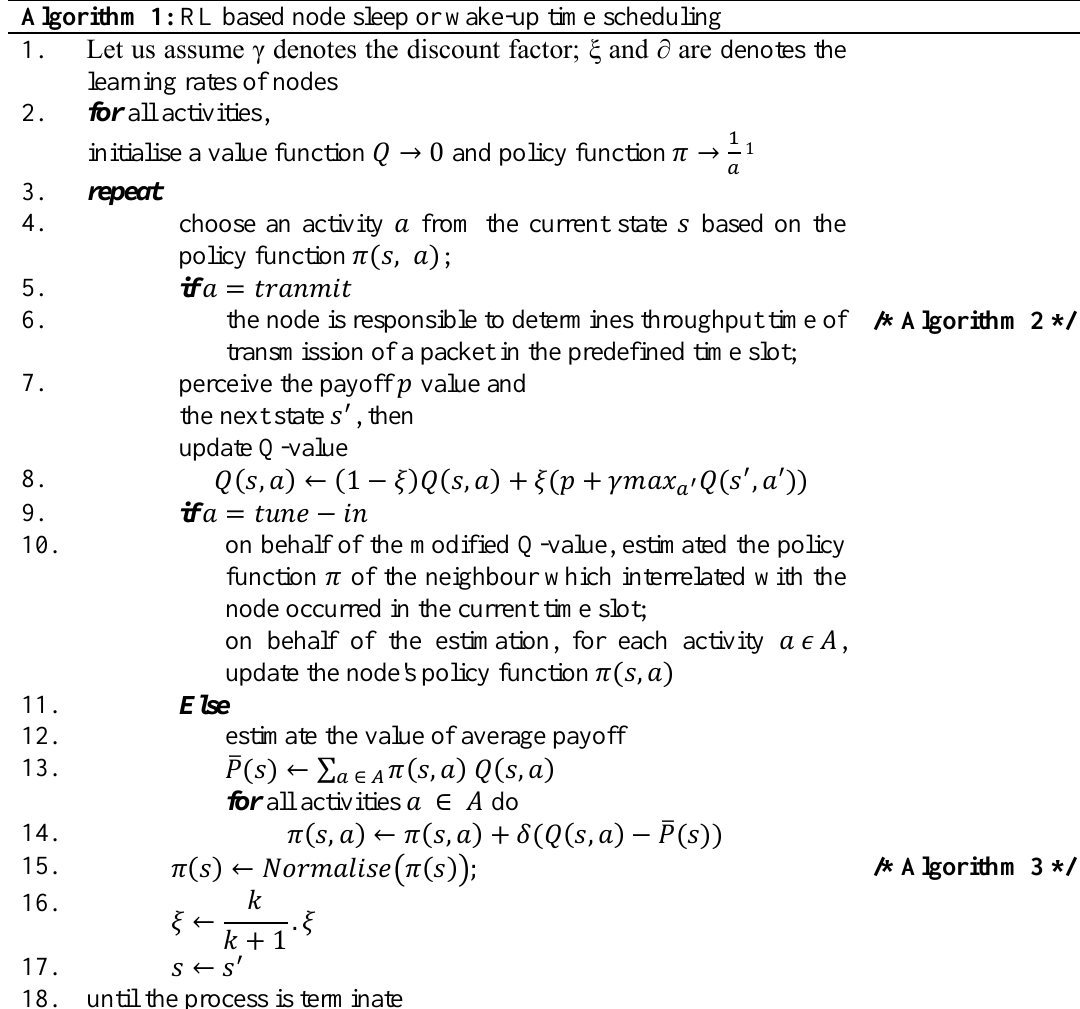
Algorithm 1: RL based node sleep or wake-up time